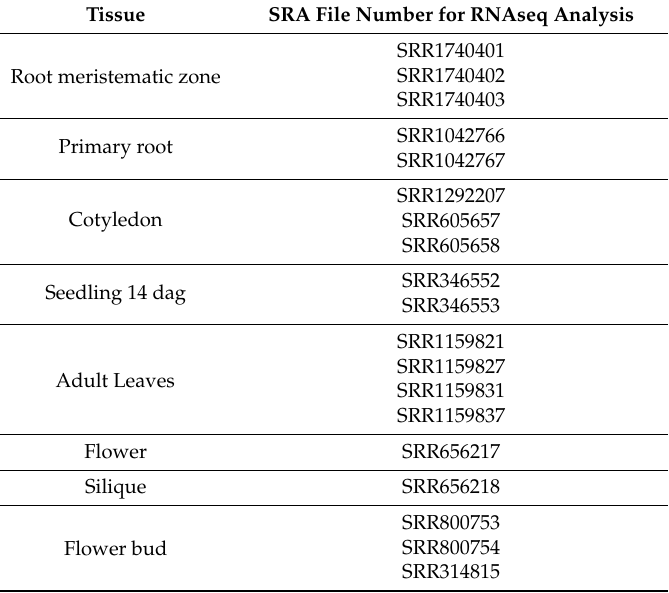
Table 3. Sequence Read Archives (SRA) files used for RNA sequencing analysis. All SRA files were downloaded from